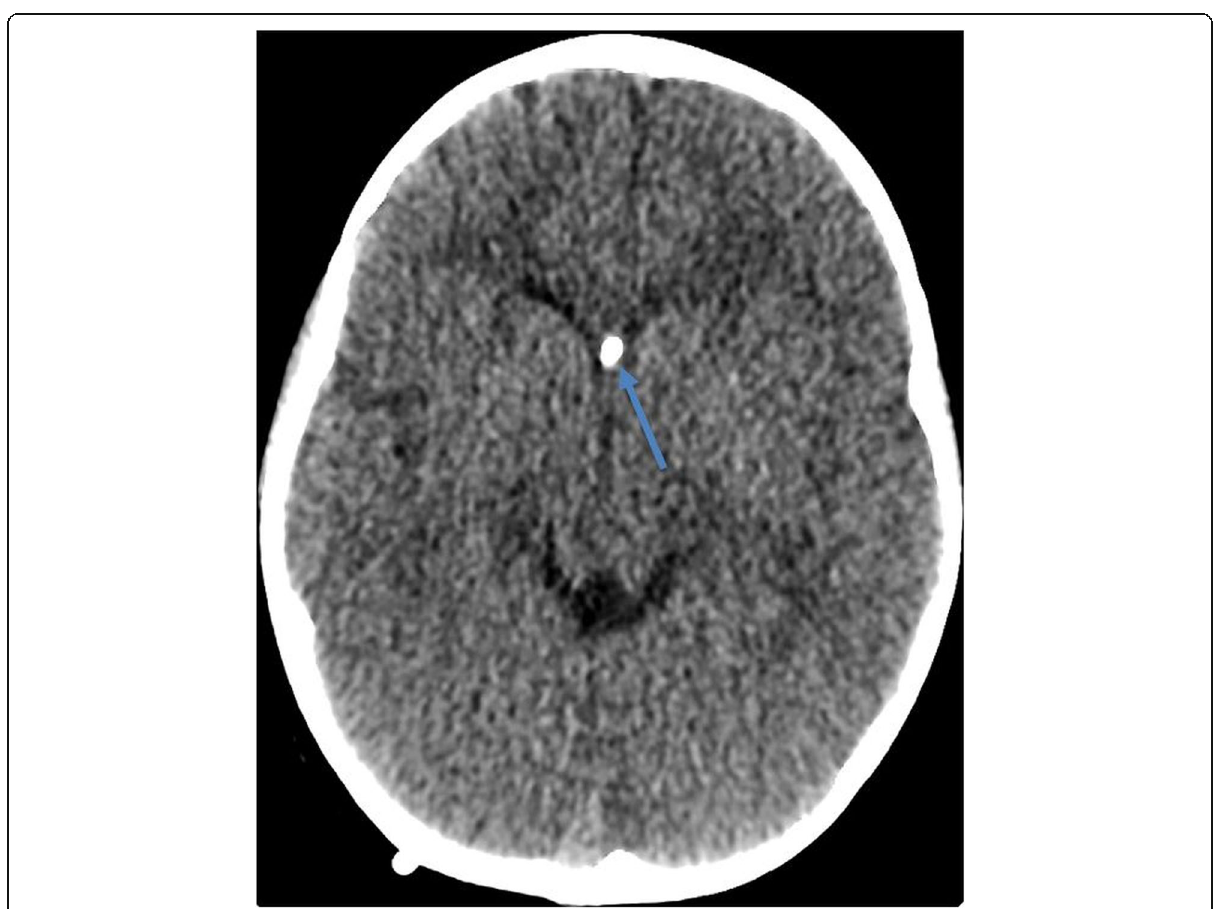
Fig. 6 Transverse head CT image (VP shunt patency protocol) of a 7-year-old female (20 kg) acquired at 6 mGy. Hydrocephalus with VP shunt (arrow) and overall image quality scored optimal by all